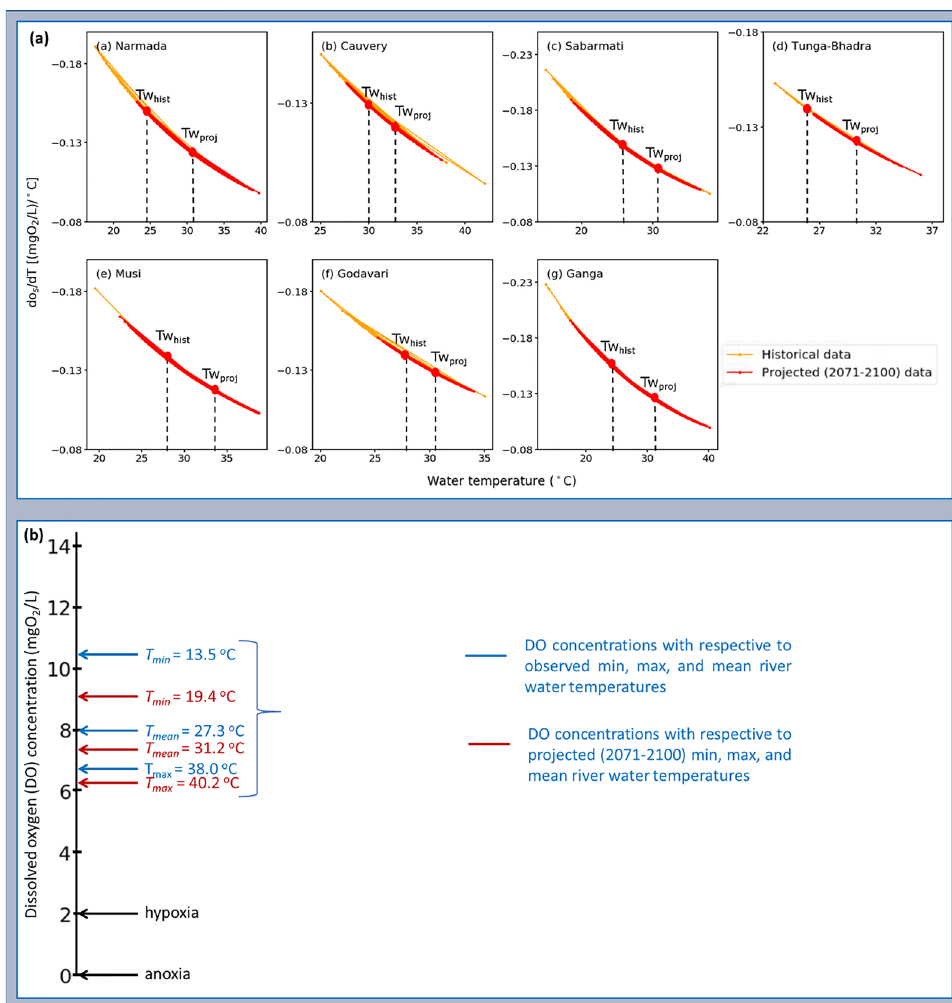
Figure 5. ( a ) The rate of change of oxygen saturation under mean river water temperature do s ( T )/ dT ((mgO 2 / L)/°C) for historical and projected (2071–2100) data for seven Indian catchments. The vertical dotted lines indicate the mean of historical (Tw hist °C) and projected (2071–2100) (Tw proj °C) water temperatures, and ( b ) the DO concentration (mgO 2 /L) scale with respect to the observed (blue color) and projected (2071–2100) (red color) minimum, maximum and mean water temperature (°C) levels of seven Indian catchments.